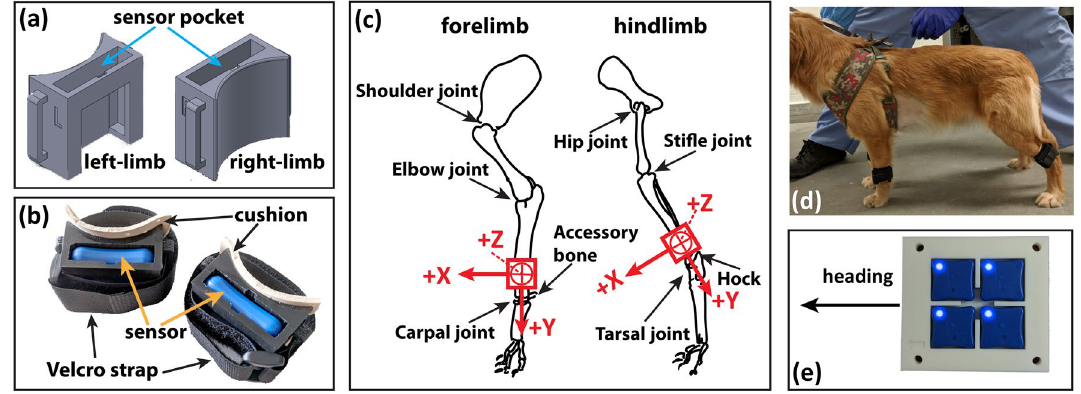
Figure 1. Illustration of sensor mounting and sensor/laboratory testing coordinates. ( a ) 3D-printed IMU sensor holder; ( b ) IMU sensors in holders with attached cushion and Velcro strap; ( c ) Mounting positions on the forelimb and hindlimb; ( d ) A dog with 4-limb sensors mounted; ( e ) Four IMU sensors placed in a synchronization board for heading direction